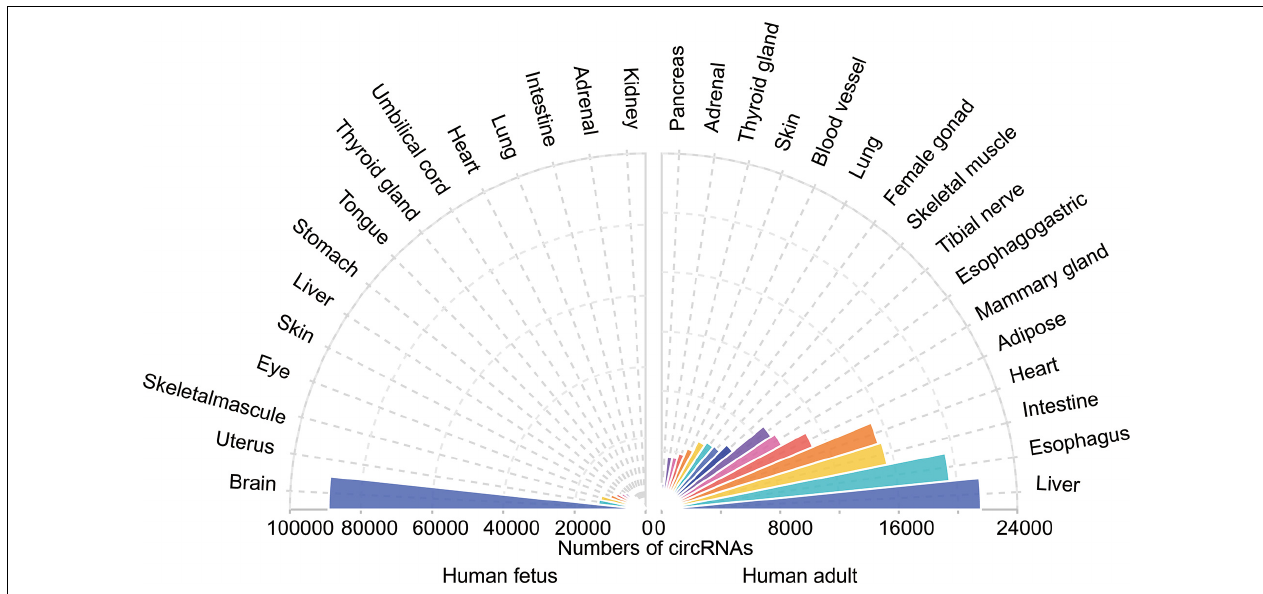
FIGURE 3 | The tissue-specific circRNAs expressed in human tissues. The colorful triangles represent the numbers of circRNAs detected in different human tissues (left, 15 human fetal tissues; right, 15 human adult tissues), respectively. CircRNAs are most abundant in the human fetus brain compared with other